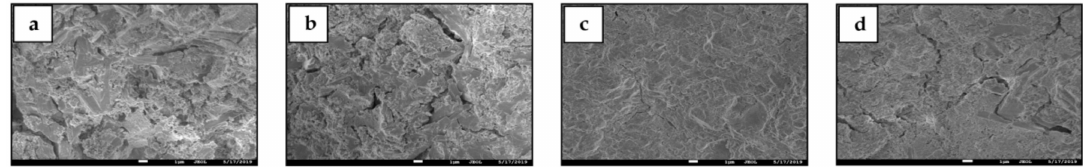
Figure 24. SEM micromorphology of GF-HBSAC-10% cement hydration products at di ff erent curing ages: ( a ) One day; ( b ) 3 days; ( c ) 7 days; ( d ) 28 days.